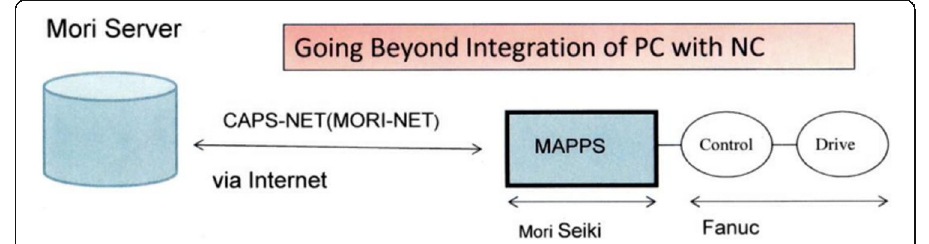
Fig. 7 Going beyond integration of PC with NC. Source: Shibata